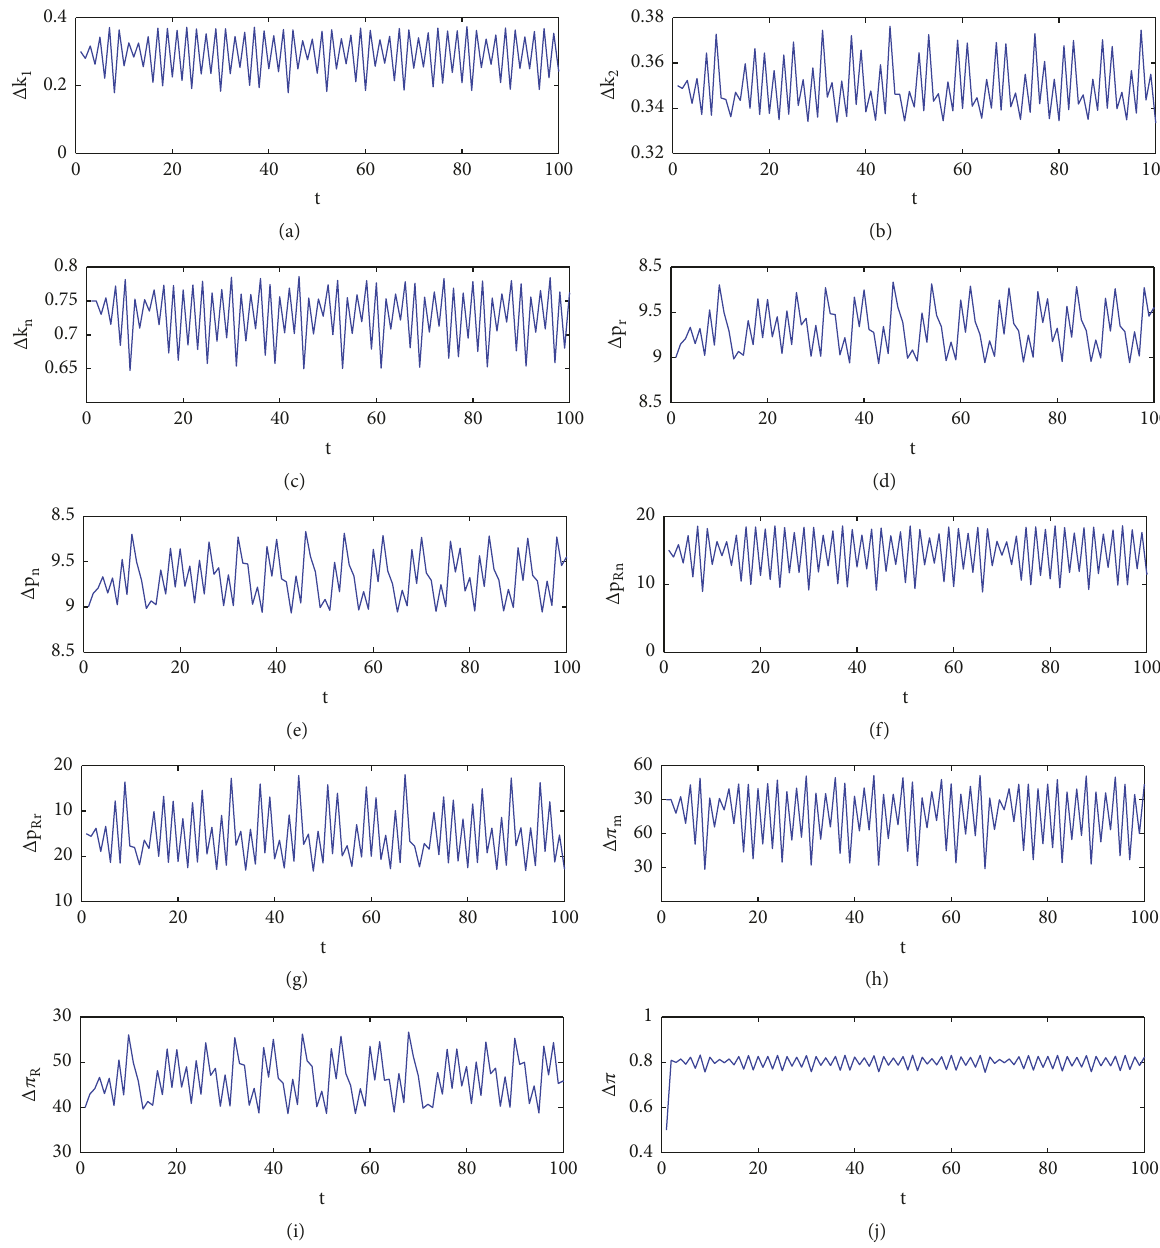
Figure 5: Sensitive dependence for the dynamical system (11) on initial